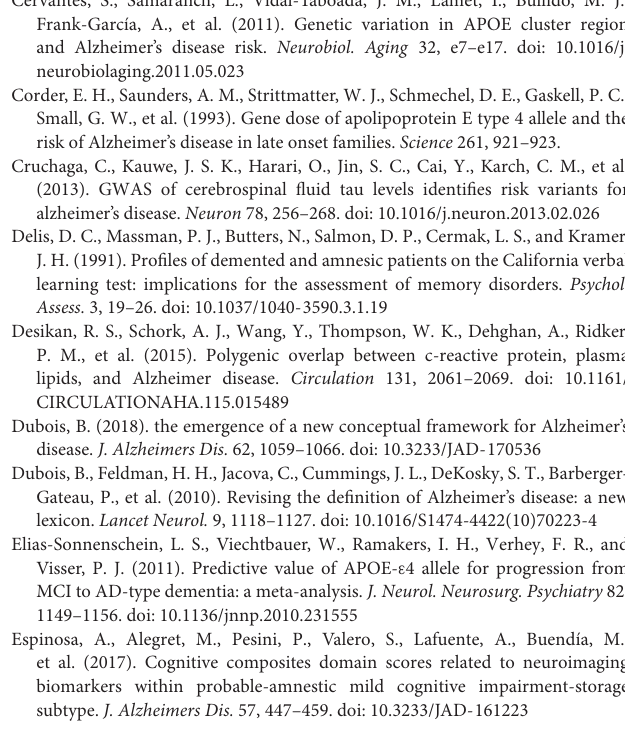
FIGURE S1 | Amnestic/non-amnestic × probable/possible MCI flowchart. (Espinosa et al., 2013; Lopez et al., 2003; Petersen, 2004). FIGURE S2 | Pr-aMCI subtype Heat Map 1) Orientation; 2) Attention and working memory; 3) Processing speed and Executive functions; 4) Language; 5) Verbal Learning and Memory; 6) Praxis; 7) Visual gnosis; 8) Global Cognition; Global orientation, summary of Temporal + Spatial + Personal orientations; WAIS-III: Wechsler Adult Intelligence Scale, Third edition; SKT: Syndrome Kurz Test; 15-BNT: the abbreviated Boston Naming Test with 15 items; Verbal learning WMS-III = 1st + 2nd + 3rd + 4thtrial scores; WMS-III: Wechsler Memory Scale, Third Edition. FIGURE S3 | Pr-aMCI-storage subtype Heat Map 1) Orientation; 2) Attention and working memory; 3) Processing speed and Executive functions; 4) Language; 5)